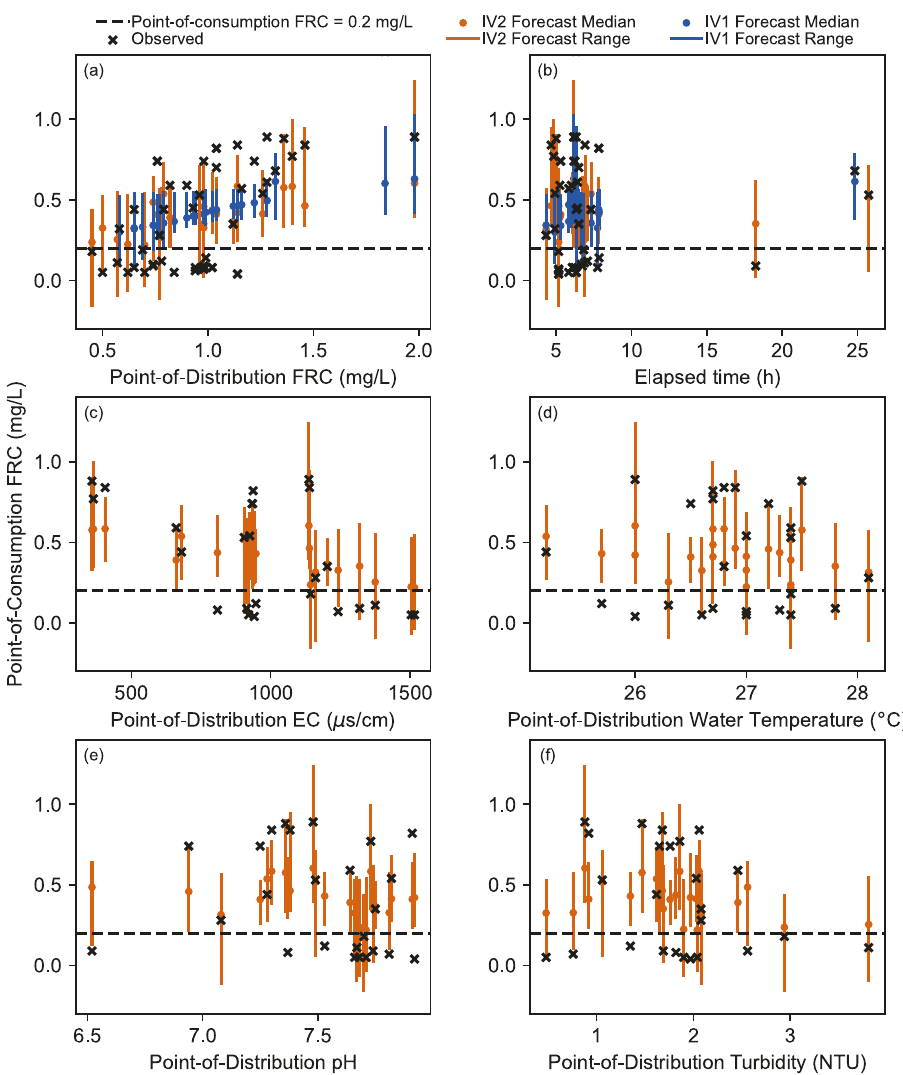
Fig. 4 Jordan (2014) observations and post-processed forecasts of point-of-consumption FRC. The observations and forecasts are shown against a point-of-distribution FRC, b elapsed time, c point-of-distribution EC, d point-of-distribution water temperature, e point-of- distribution pH, f point-of-distribution turbidity. IV1 forecasts show a strong regression to the mean behaviour. Strong trends between point- of-consumption FRC and: point-of-distribution FRC, EC, and water